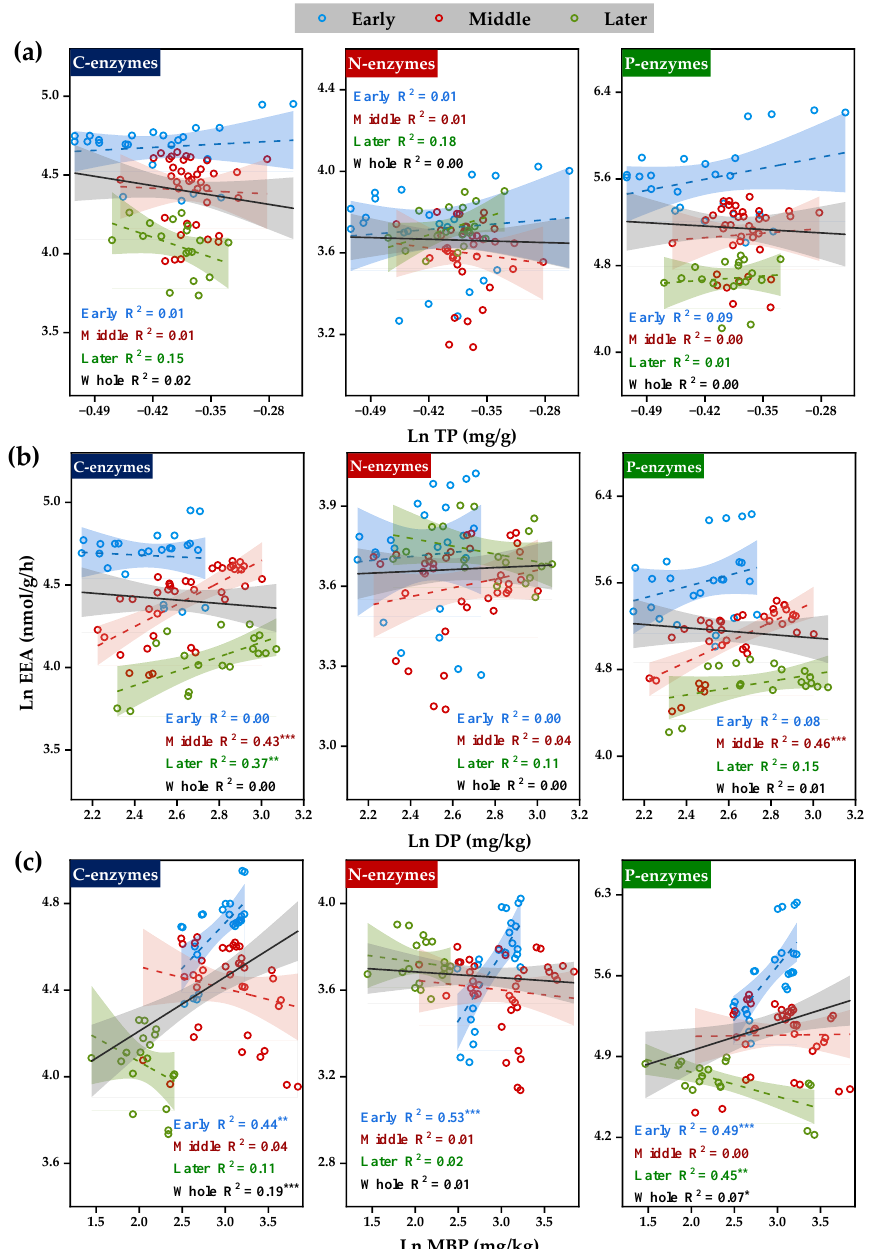
Figure 5. Relationship between soil extracellular enzyme activities (EEAs) and soil phosphorus fractions. ( a ) C-enzymes (BG+CBH) and total phosphorus (TP); N-enzymes (LAP+NAG) and TP; P-enzymes (AP) and TP. ( b ) C-enzymes and dissolved phosphorus (DP); N-enzymes and DP; P-enzymes and DP. ( c ) C-enzymes and microbial biomass phosphorus (MBP); N-enzymes and MBP; P-enzymes and MBP. * p < 0.05, ** p < 0.01, and *** p < 0.001.